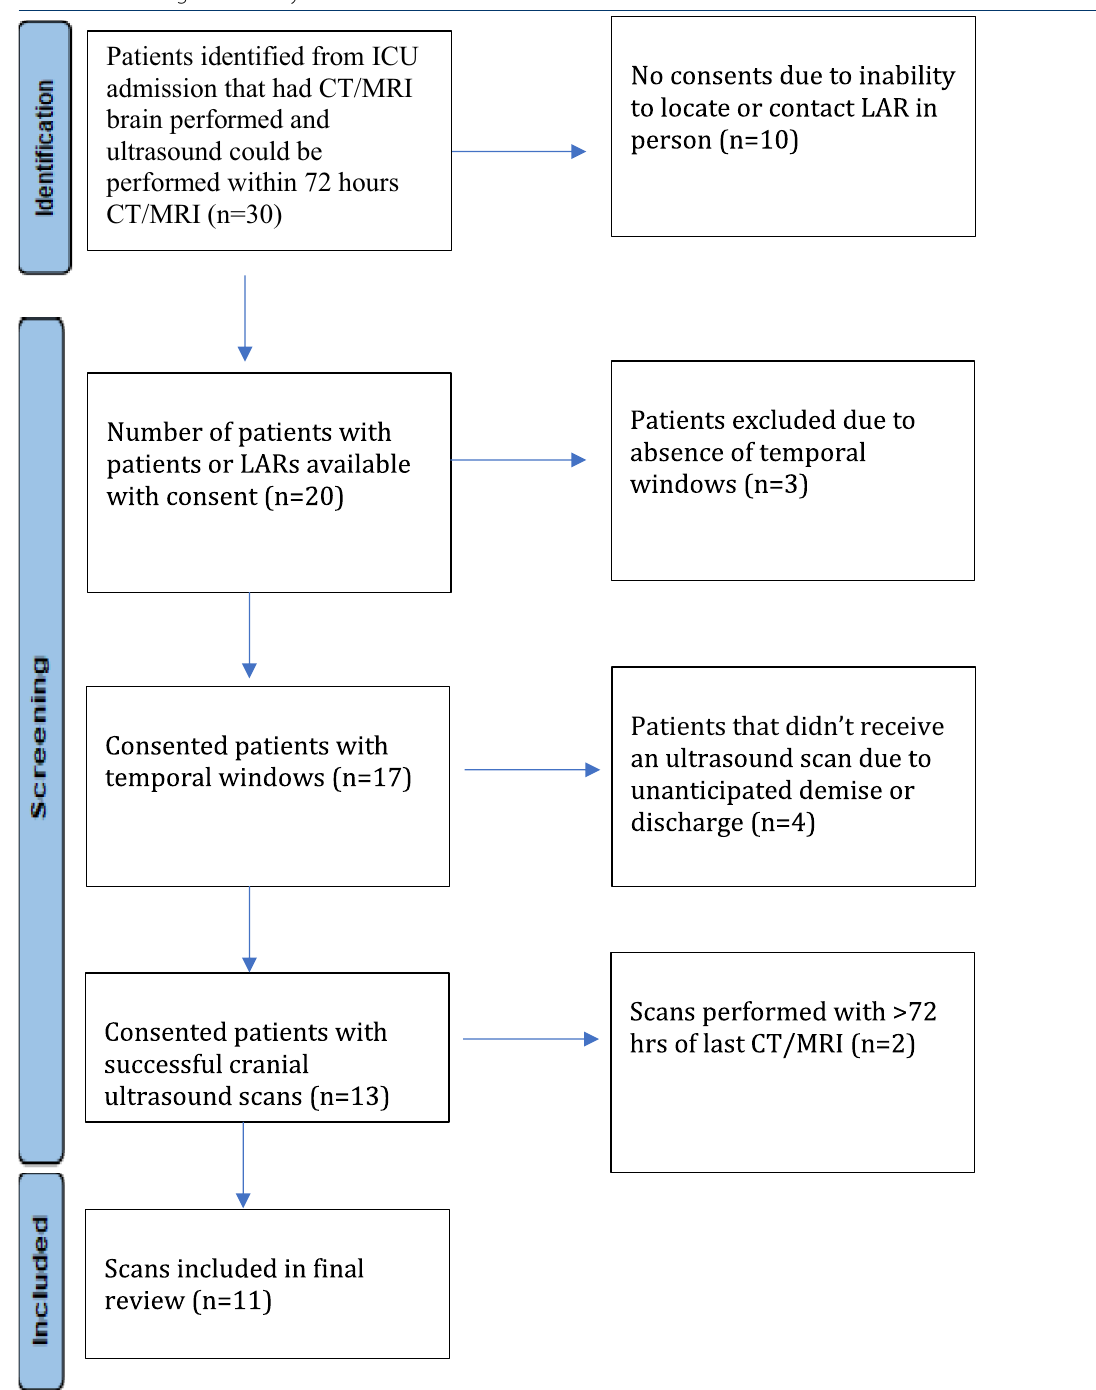
Table 1 Flow diagram of study